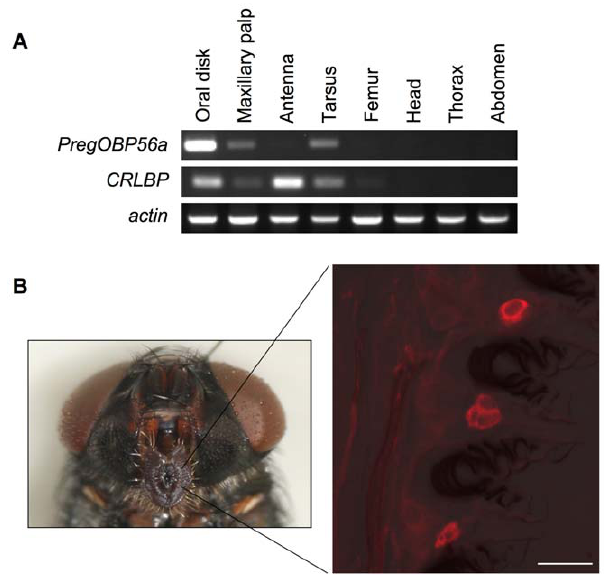
Figure 3. Expression of PregOBP56a . A, Tissue specificity of PregOBP56a expression. cDNA was synthesized from total RNA extracted from each experimental tissue at day 0 adult stage. Gene expression was detected by RT-PCR. actin expression was used as an internal control. PregOBP56a was highly expressed in the oral disk. In contrast CRLBP , an OBP related to chemical reception, was expressed in the oral disk and antenna. B, Cellular localization of PregOBP56a expression in the oral disk by in situ hybridization. Sense and anti-sense